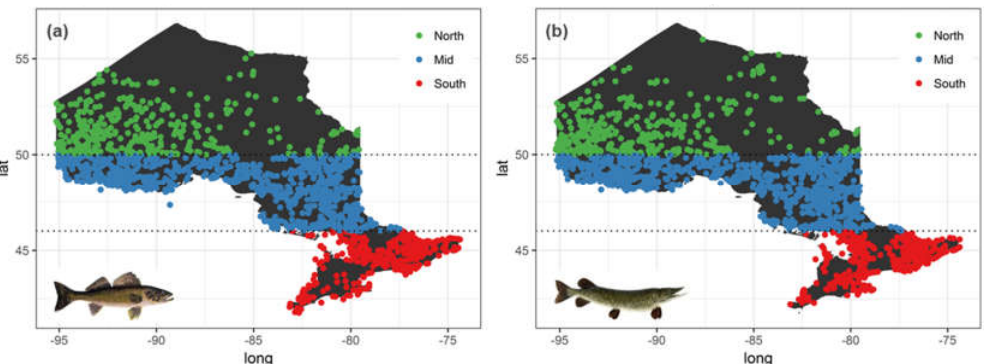
Figure 1. Long-term distribution of fish mercury samples for ( a ) Walleye and ( b ) Northern Pike ranging from 1975–2015 gathered by Ontario Ministry of Environment, Conservation and Parks (OMECP).